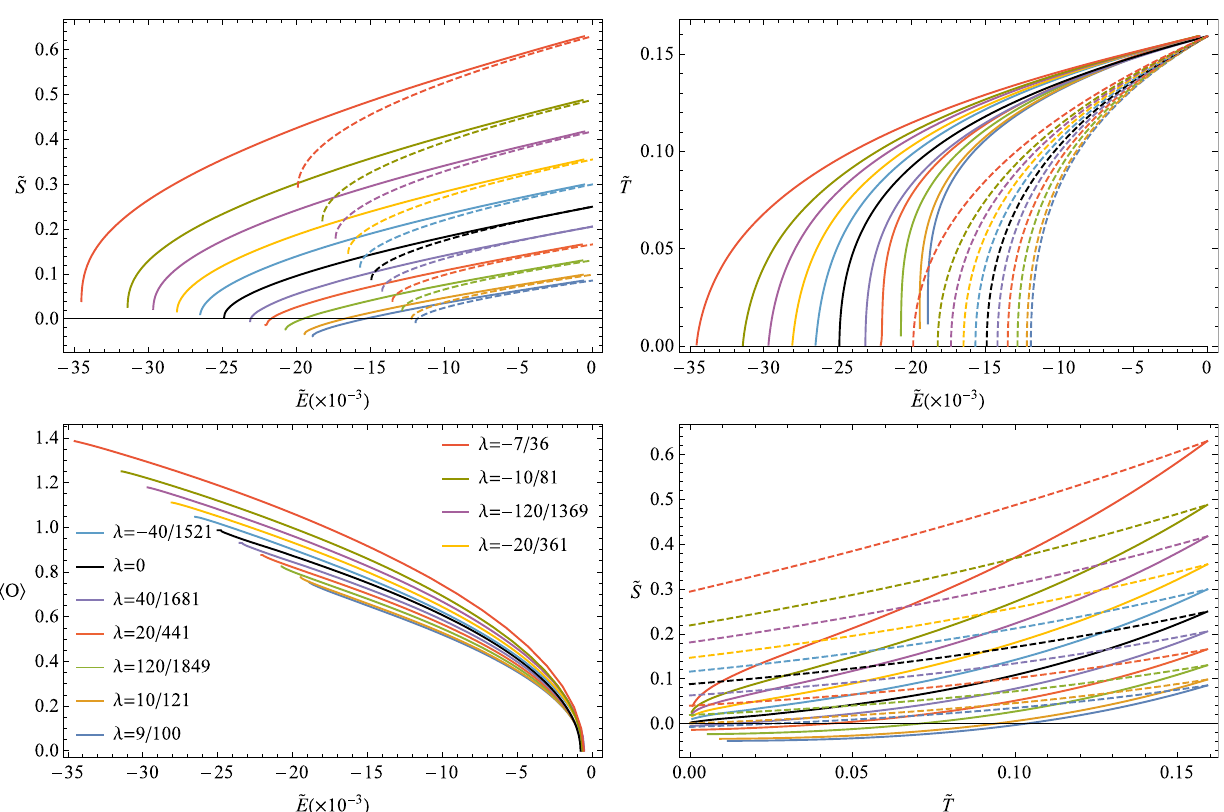
Fig. 7 The thermodynamical quantities for the various values of λ when (cid:16) + = 2. The colors in these graphs are matched with those in Fig. 6. In each graph, a horizontal black line is sketched to guide the